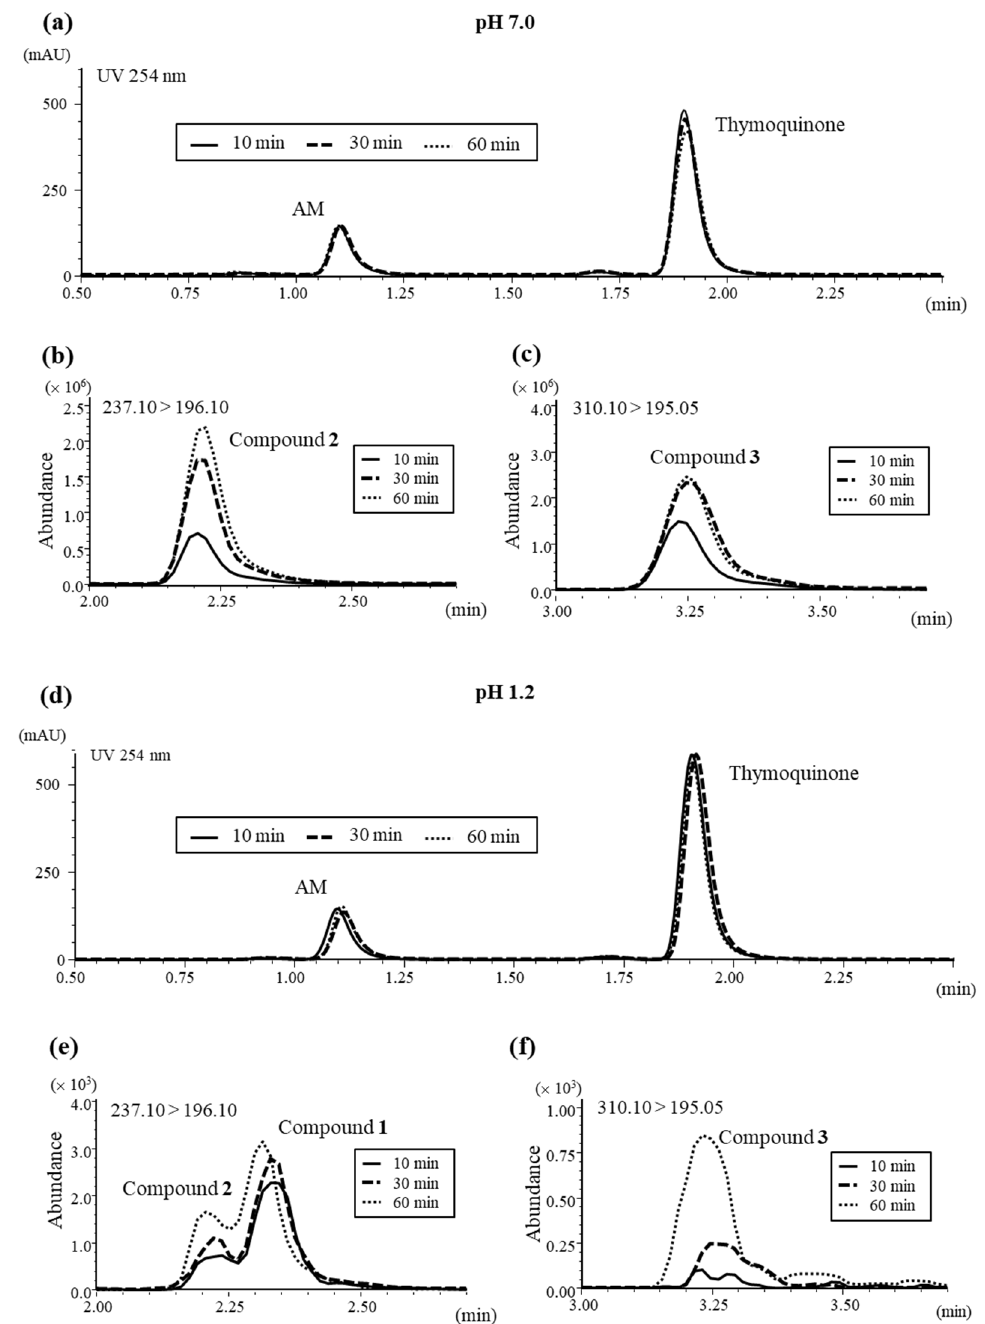
Figure 5. The chromatograph after reaction with 400 µ g of thymoquinone and AM: ( a ) HPLC chart at 254 nm of thymoquinone and AM after reaction at pH 7.0, ( b ) MS chromatograph (MRM 237.10 > 196.10) after reaction at pH 7.0, ( c ) MS chromatograph (MRM 310.10 > 195.05) after reaction at pH 7.0, ( d ) HPLC chart at 254 nm of thymoquinone and AM after reaction at pH 1.2, ( e ) MS chromatograph (MRM 237.10 > 196.10) after reaction at pH 1.2, ( f ) MS chromatograph (MRM 310.10 > 195.05) after reaction at pH 1.2. All experiments were performed at 37 ◦